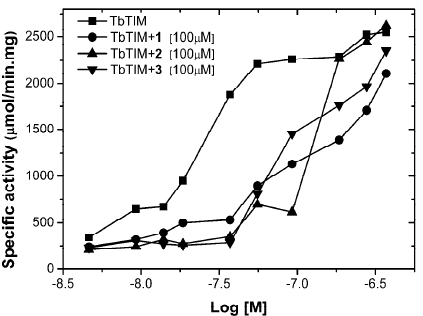
Figure 3. Effect of compounds 1 , 2 and 3 at different concentrations of TbTIM.